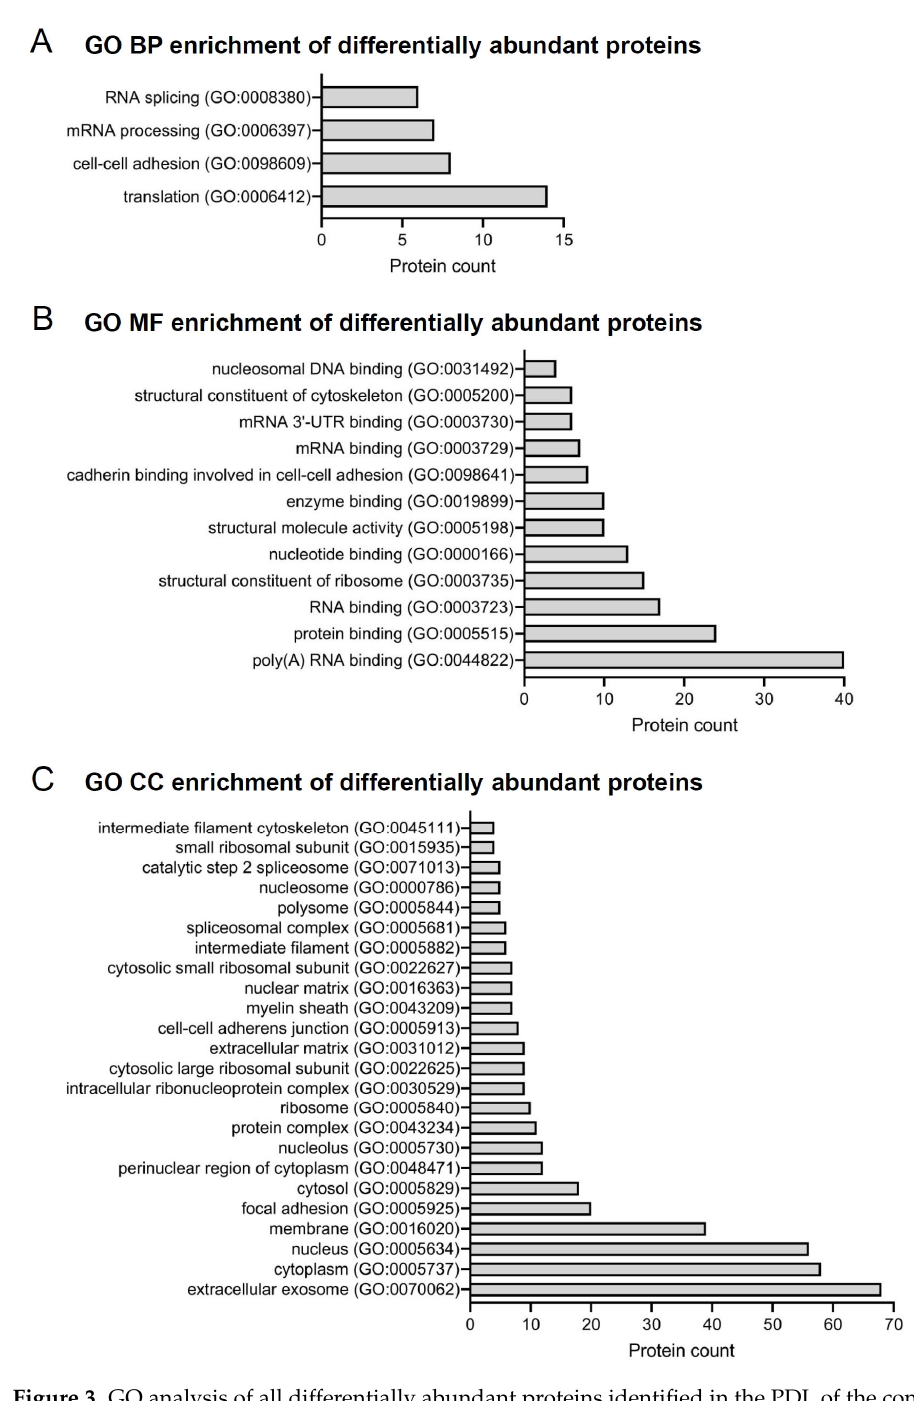
Figure 3. GO analysis of all differentially abundant proteins identified in the PDL of the control and obese groups. ( A ) Graph representing the differentially detected proteins in the GO BP terms related to “translation” (GO:0006412), “cell-cell adhesion” (GO:0098609), “mRNA processing” (GO:0006397), and “RNA splicing” (GO:0008380). ( B ) Graph demonstrating the differentially abundant proteins in the GO MF terms especially related to “poly(A) RNA binding” (GO:0044822), “protein binding” (GO:0005515), “RNA binding” (GO:0003723), and “structural constituent of ribosome” (GO:0003735). ( C ) Differentially, proteins were detected in the GO CC terms, which were the largest category of differentially identified proteins, as they were related to 24 enriched terms, such as “extracellular exosome” (GO:0070062), “cytoplasm” (GO:0005737), “nucleus” (GO:0005634), and “membrane” (GO:0016020). The number of proteins associated with each GO enrichment term is